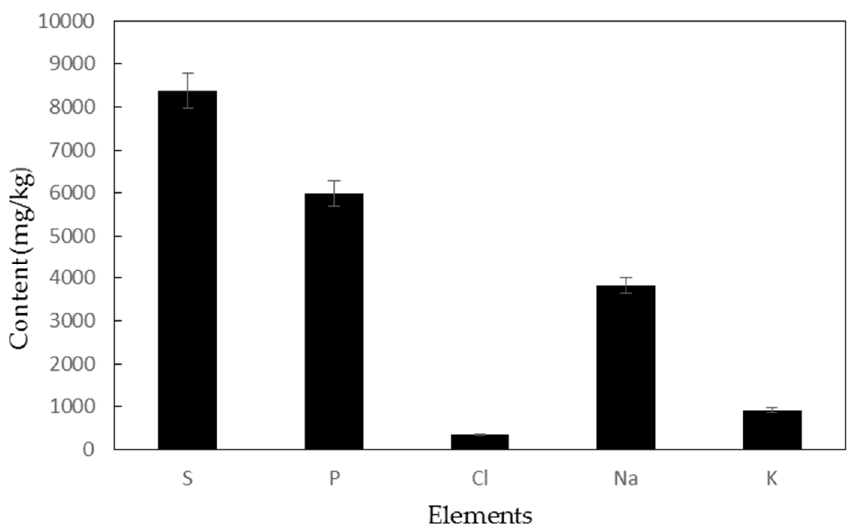
Figure 3. Contents of S, P, Cl, Na, and K in Cq sludge.